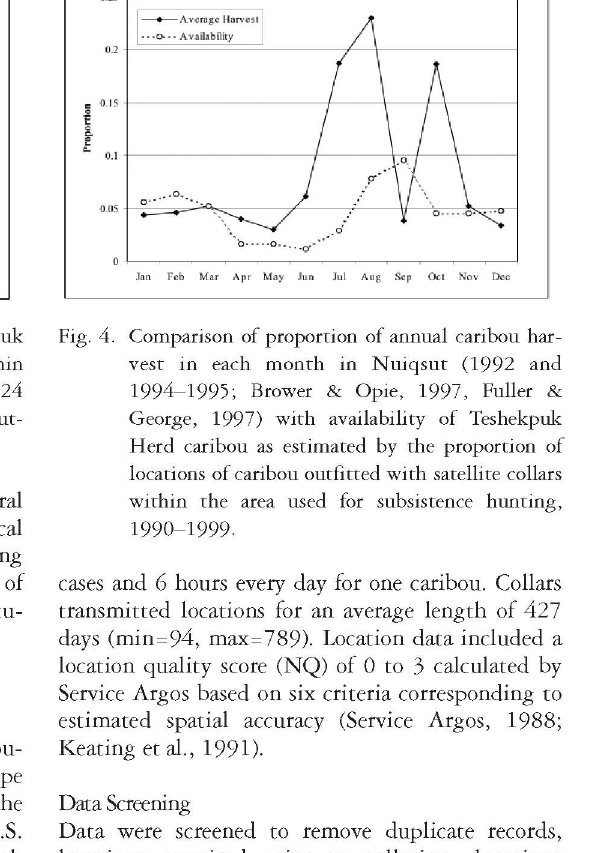
Fig. 4. Comparison of proportion of annual caribou har¬ vest in each month in Nuiqsut (1992